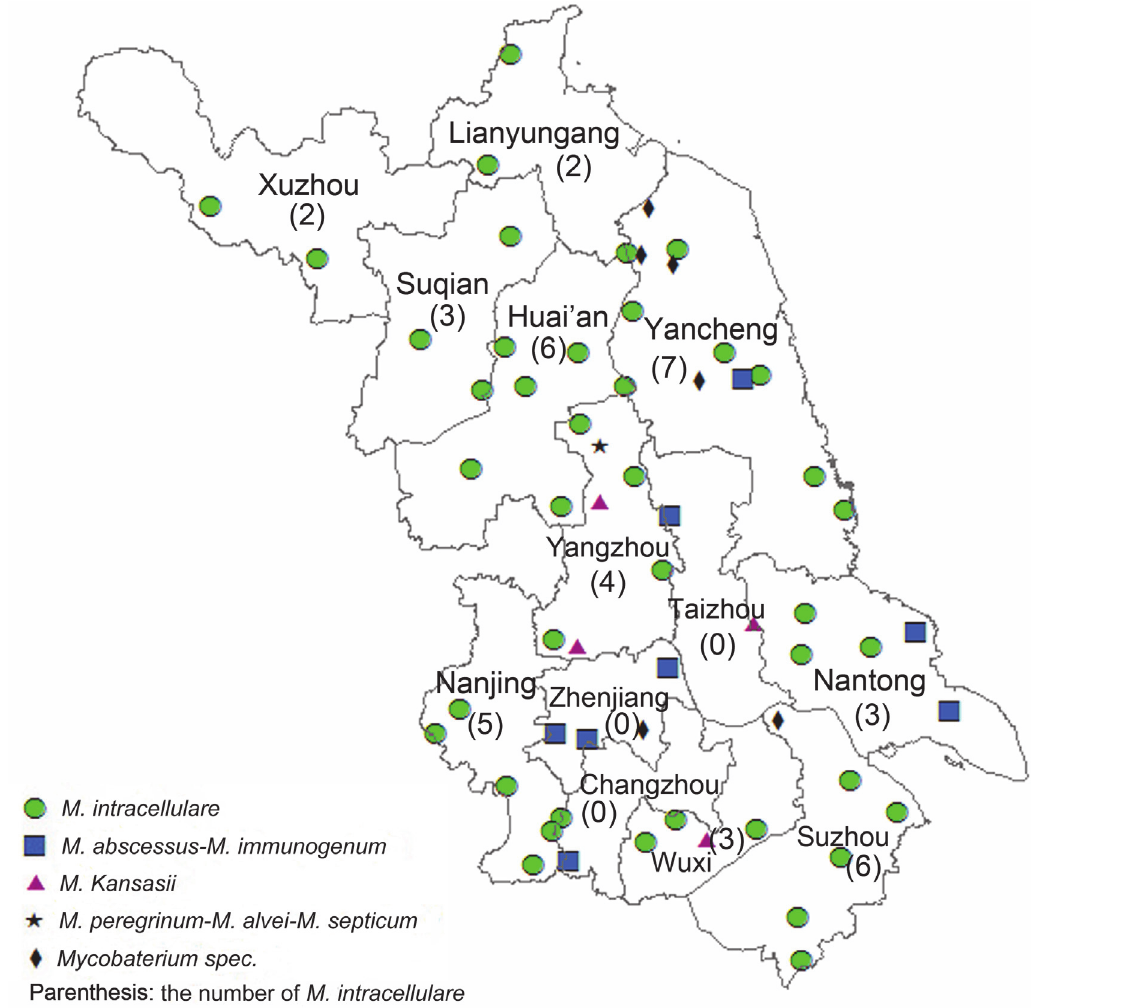
Fig 2. Geographical distribution of NTM in Jiangsu province. Data presented as number of M . intracellulare strains.